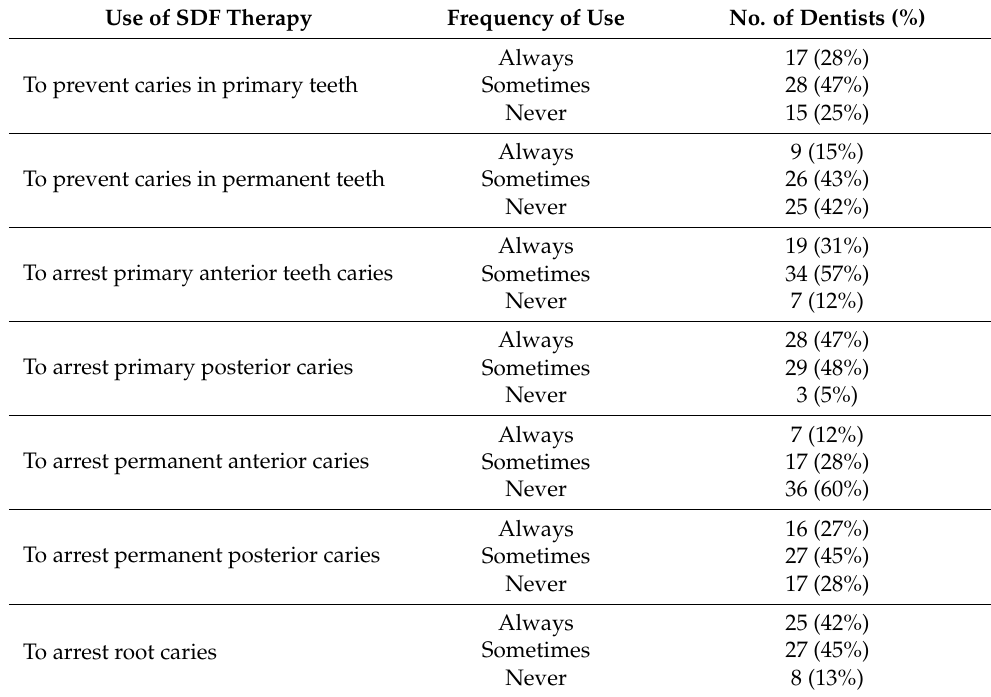
Table 5. Dentists’ practice of SDF therapy ( n =